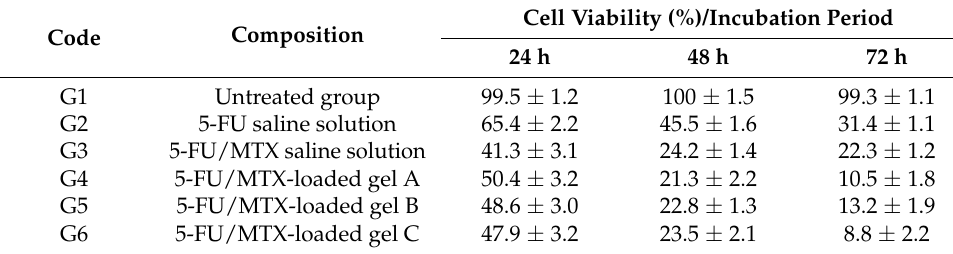
Figure 5. Cytotoxicity assay (% of cell viability), as a function of the incubation period, of the modified gel systems; G4 (8armPEG20k-CD/8armPEG20k-chol), G5 (p β -CD/8armPEG20k-Ad), and G6 (p β -CD/8armPEG20k-chol) compared with G2 (5-FU free saline solution) and G3 (5-FU/MTX free saline solution) against MCF-7 breast cancer cell line. The results are presented as the average of three independent measurements ± SD. Table 5. The percentage of breast cancer cell viability measurements as a function of the incubation period for all modified hydrogel systems compared to either free drug solutions or untreated groups, taking 200 µ g/mL as a fixed concentration for all